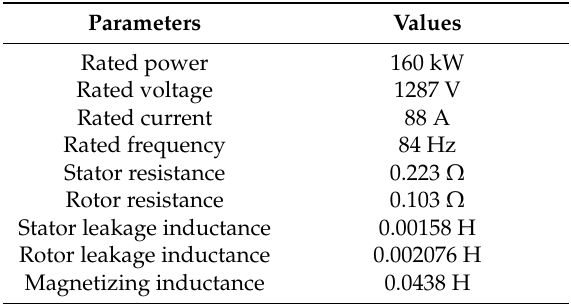
Table 2. Parameters of the induction motor in simulations.